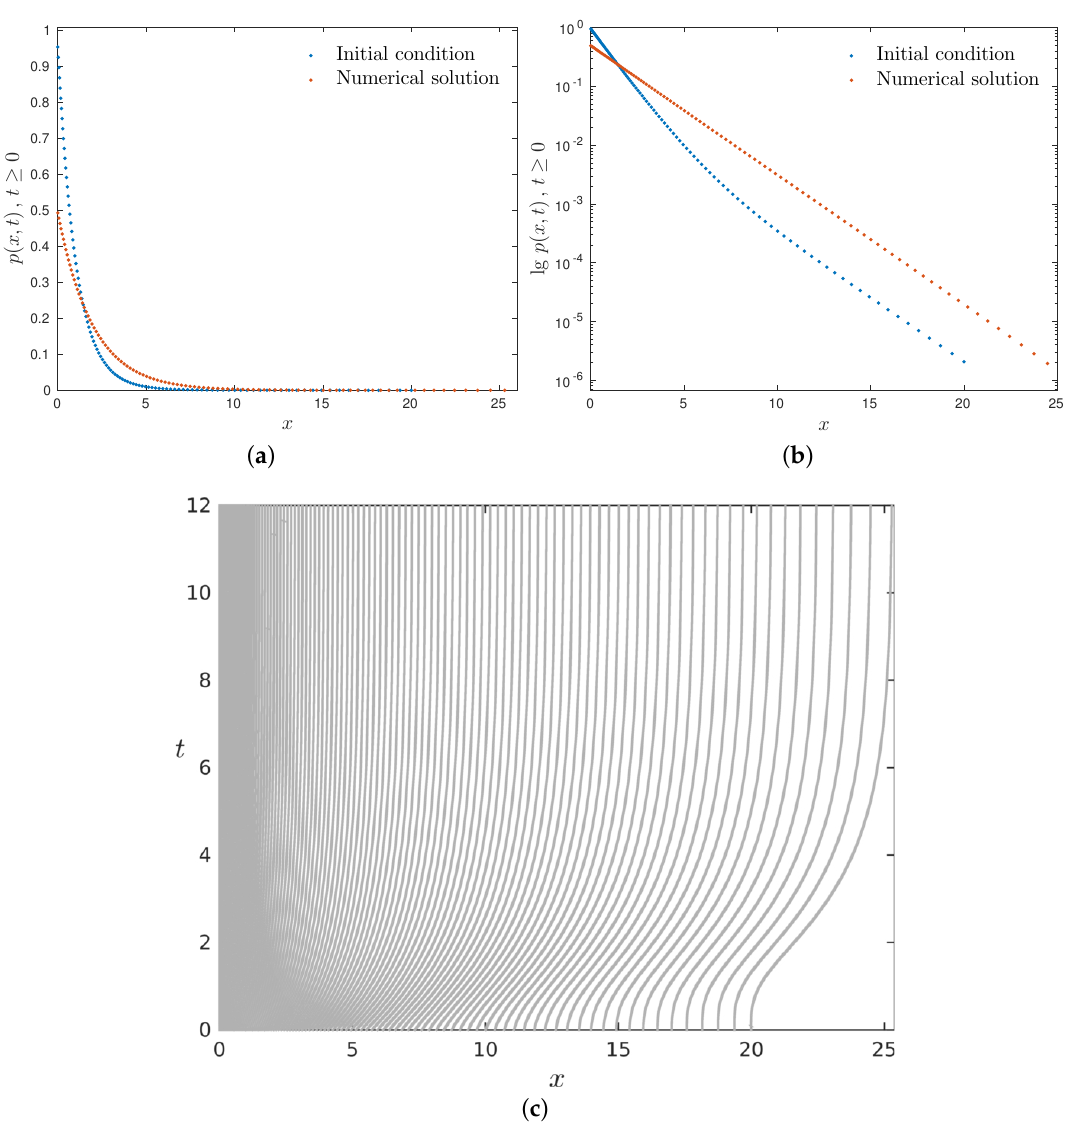
Figure 3. Numerical result of the confining experiment with positive drift γ = 0.5 > 0: ( a ) initial and terminal states of the numerical discretized solution; ( b ) initial and terminal states of the numerical discretized solution in semilogarithmic coordinates; and ( c ) trajectories of grid nodes. All numerical parameters for this computation are reported in Table 2 (right